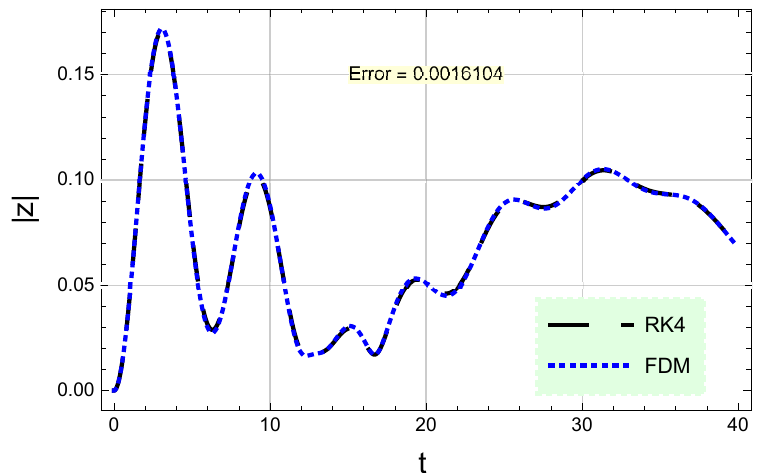
Figure 5. The numerical approximation for the absolute value | z | using the FDM is compared with Fig. 5 the numerical RK4